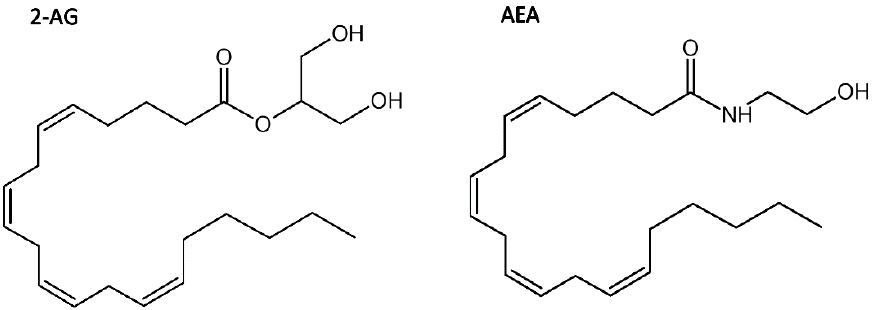
Figure 1. Chemical structures of endocannabinoids: 2-arachidonylglycerol (2-AG) and anandamide